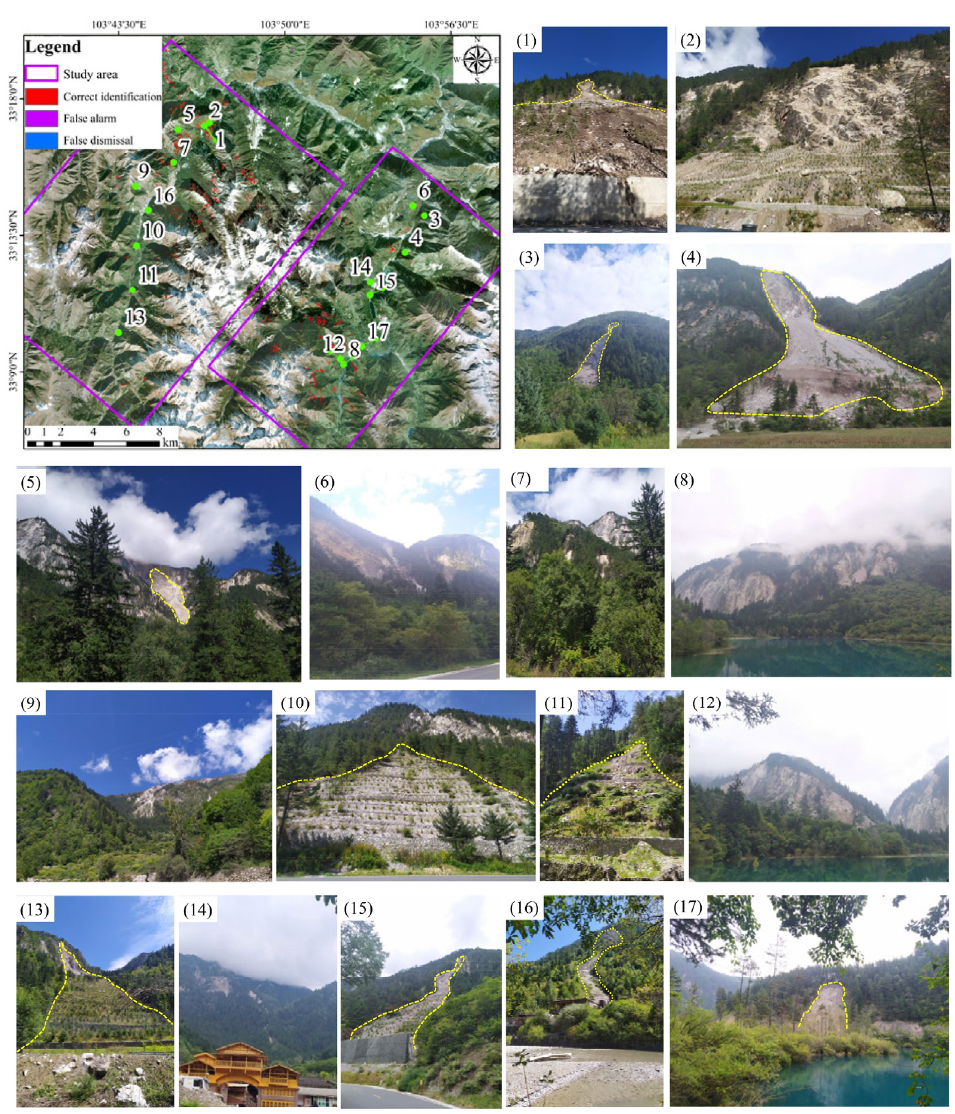
Figure 10. Some field validation photos of coseismic landslides. Photos (1)–(17) show 17 typical cases. Table 5. Environmental classes and landslide sizes in three subregions.